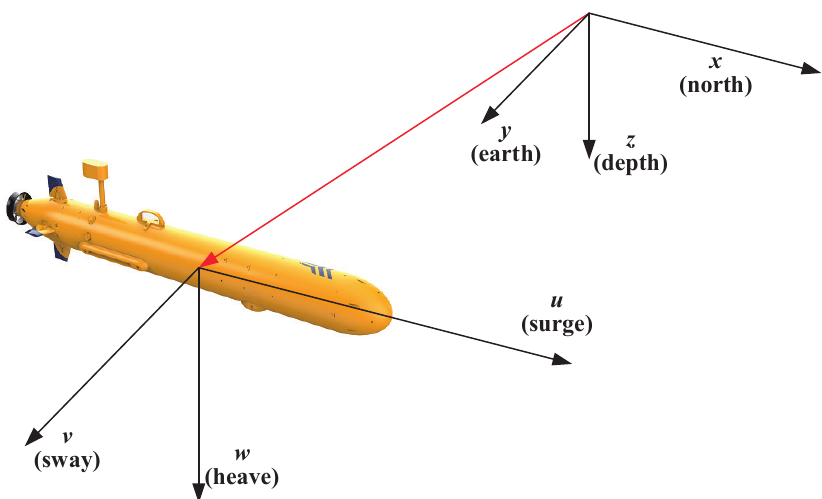
Figure 2. Model diagram of underactuated AUV in inertial and fixed